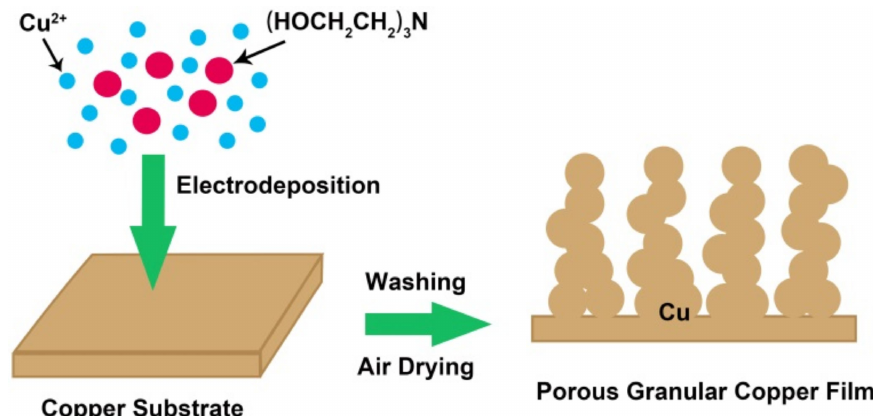
Figure 3. The schematic diagram of the GCF formation